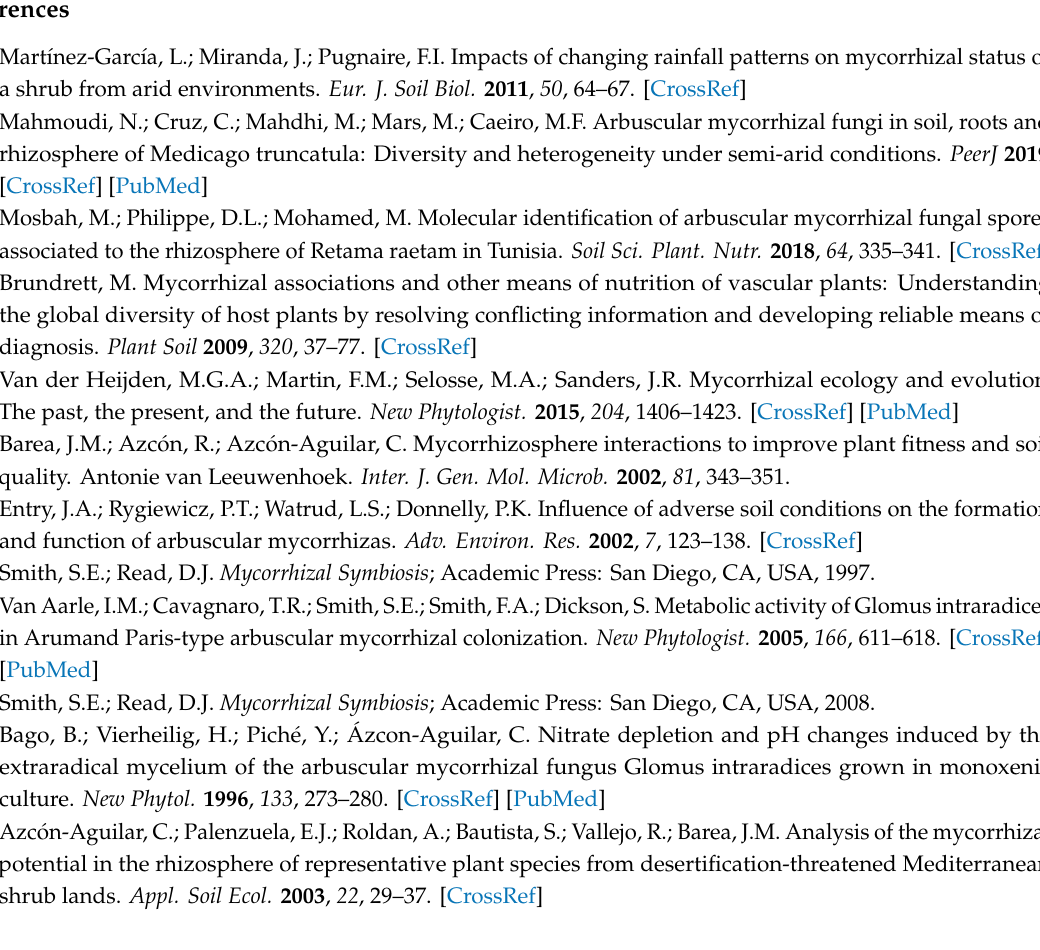
Figure S1: Linear regression to model the correlations between mycorrhizal proprieties (mycorrhizal frequency, mycorrhizal intensity, and number of spores) and the microbiological parameter microbial biomass carbon. The analyses included all available data: from the rhizospheres of the four plants and from bulk soil, Figure S2: Linear regression to model the correlations between mycorrhizal proprieties (mycorrhizal frequency, mycorrhizal intensity, and number of spores) and biochemical activities: phosphatase (in µ g PNP. g − 1 soil · h − 1 ), dehydrogenase ( µ g INTF. g − 1 soil · h − 1 ) and β -glucosidase ( µ g PNP. g − 1 soil · h − 1 ). The analyses included all available data: from the rhizospheres of the four plants and from bulk